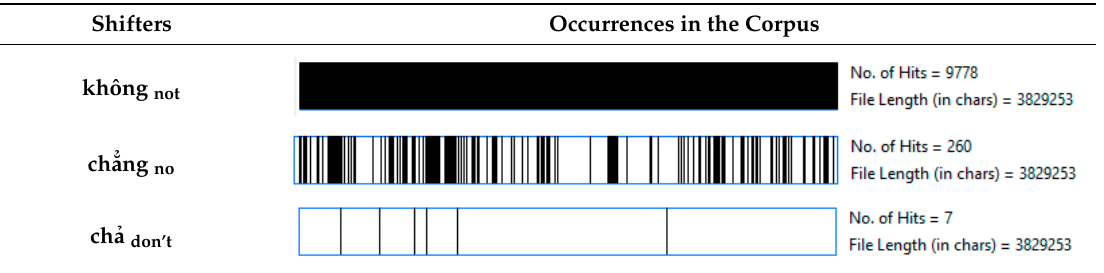
Table 3. Statistics realized depending on some negation words’ occurrences in Vietnamese language corpus of hotel reviews.